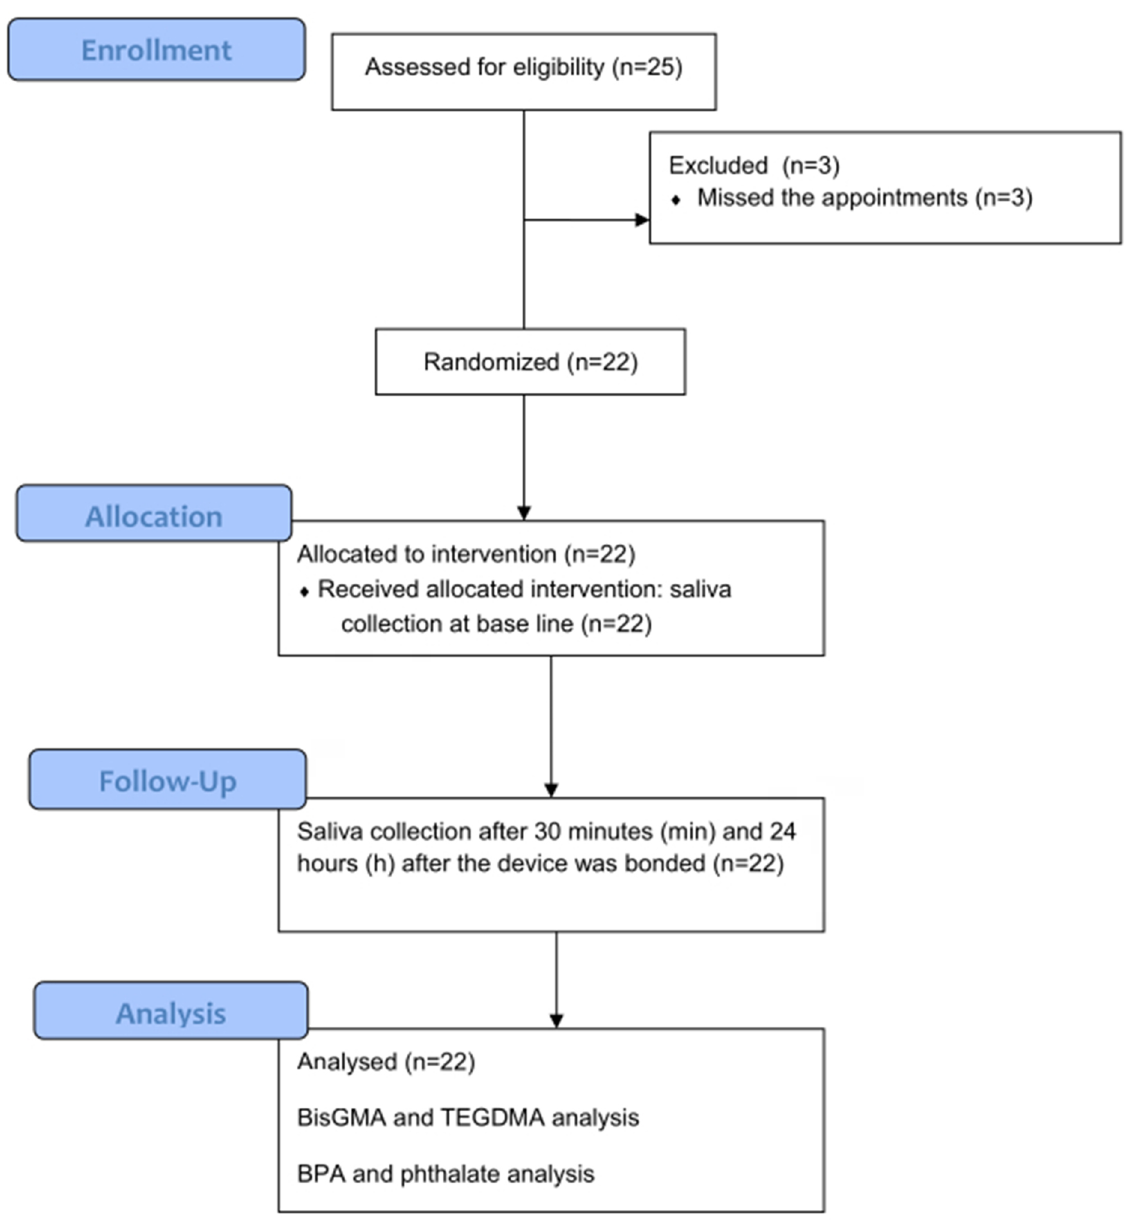
Figure 1- Participant flow